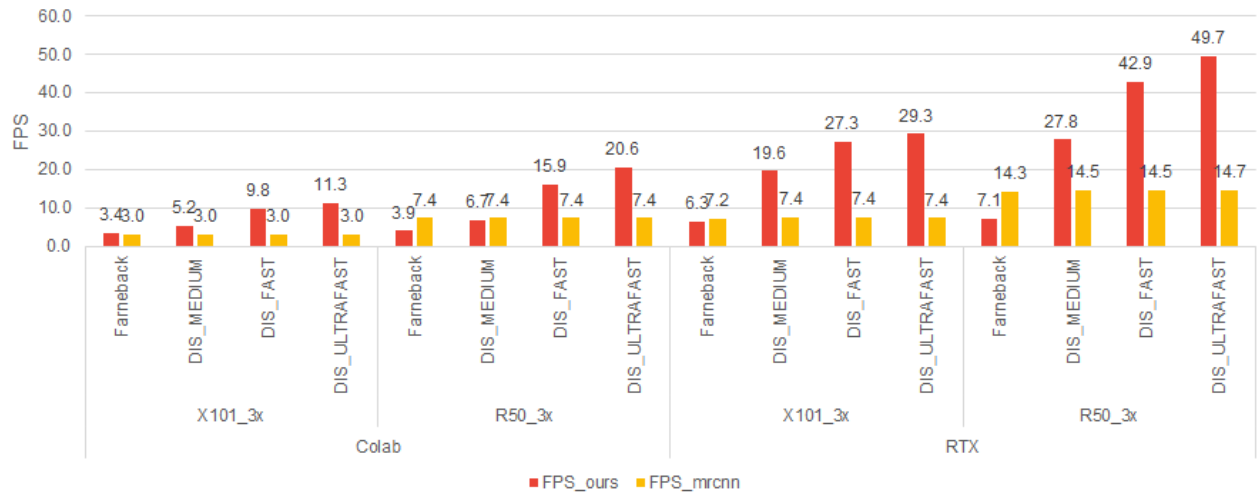
Figure 12. Time—Own dataset, RTX and Colab platforms.